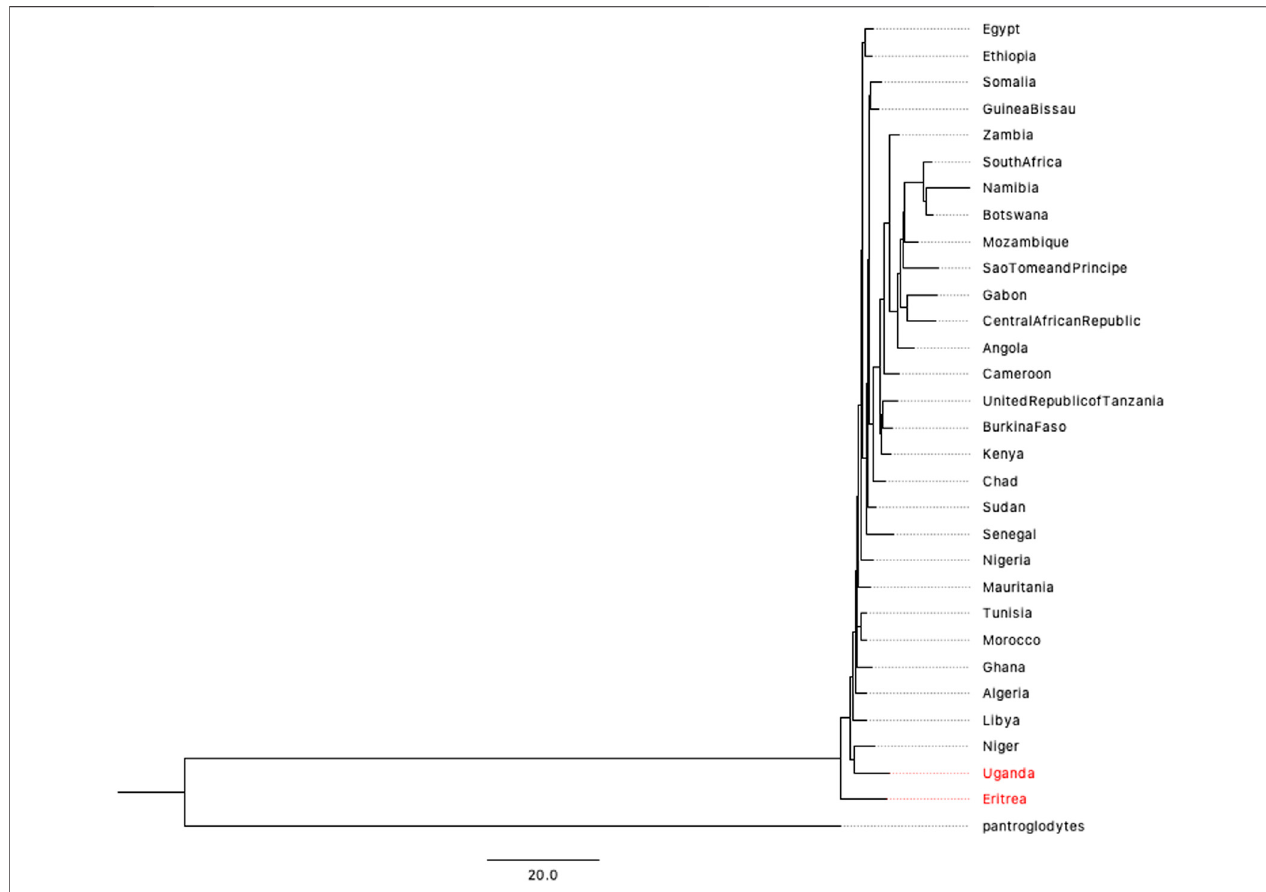
FIGURE 4 | BIONJ tree of 30 countries on African continent based on the mitochondrial data of 2932 individuals (with Pan troglodytes as the outgroup).